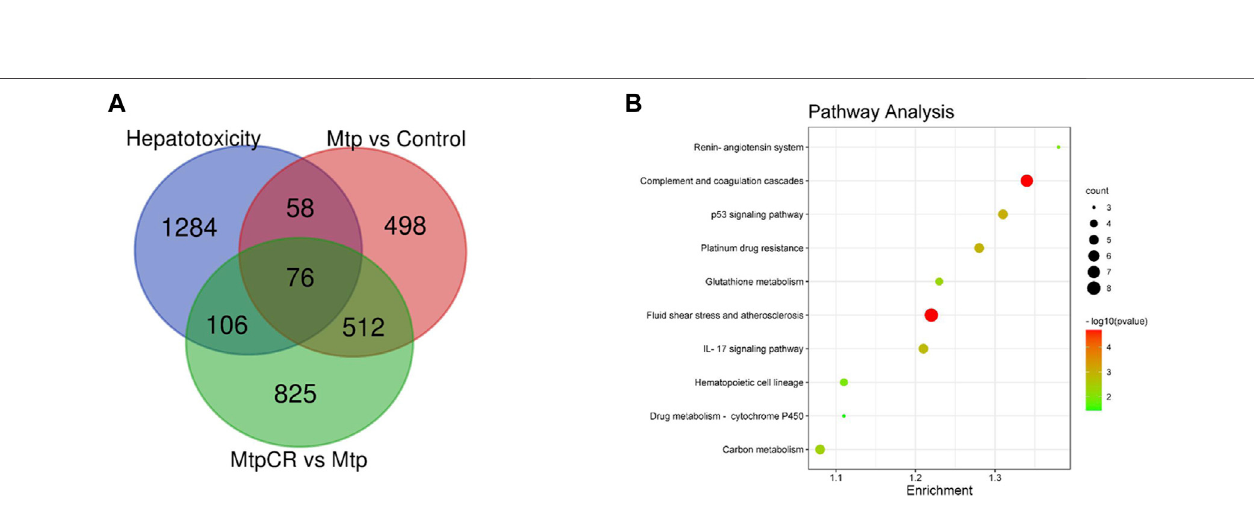
FIGURE 11 | Venn diagram showing the number of differently expressed mRNAs related to hepatotoxicity (A) and pathway enrichment analysis (B) .